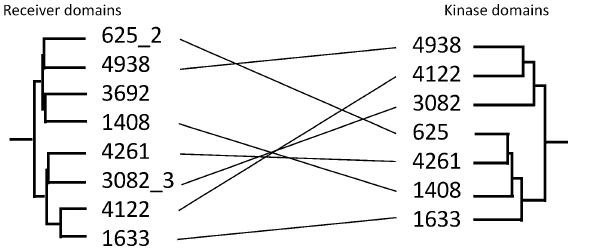
Figure 1. Paired phylogenetic trees from Pseudomonas brassicacearum , focusing on the ‘GacS cluster’. Black lines connect hybrid HKs to their internal receivers. A number is added to the protein identifier to indicate the position of the receiver, in the case of multiple receiver domains (i.e. 3082_3: third receiver of 3082). All the HKs of the GacS cluster are transmembrane proteins.